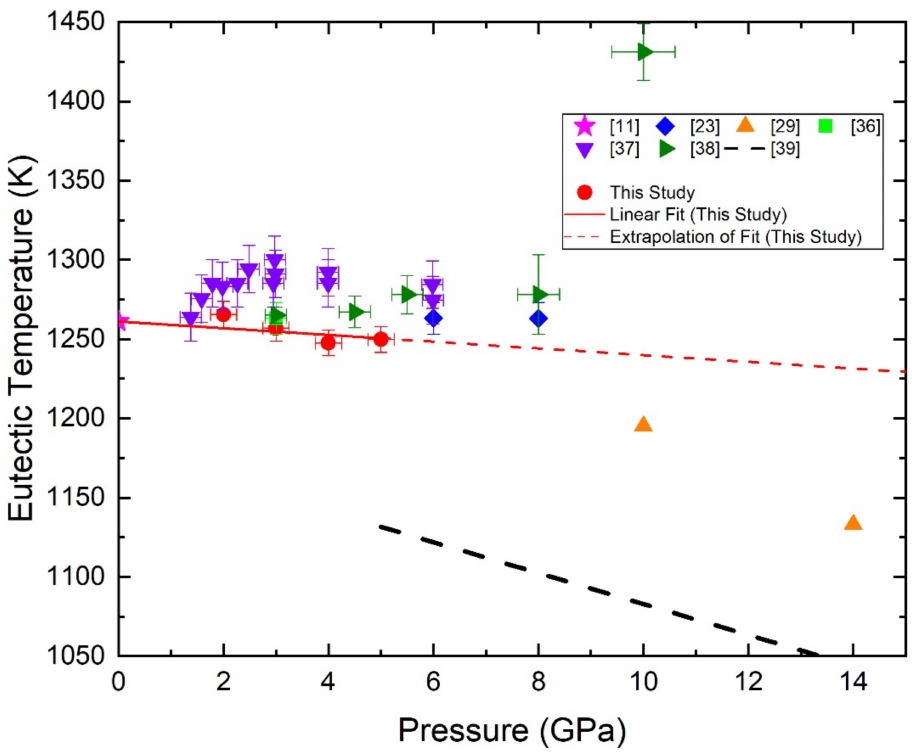
Figure 3. Experimentally determined eutectic temperatures of the Fe-FeS system as a function of pressure. The results of this work are compared to several previous works [11,23,29,36–39]. Estimates of P within the core of Ganymede range from ~5 GPa at the core–mantle boundary (CMB) to ~11 GPa at its center and T at the CMB span ~1250–2100 K [3,5,7,9,10]. We adopted the same procedure to calculate adiabatic heat flow (Q a ) at the top of Ganymede’s core as Littleton et al. [21], although for the current study two linear fits to interpolate and extrapolate values of ρ at 5 GPa between 1250 and 1450 K were used, as shown in the Appendix (Figure A1). A positive linear fit (with ( ∂ ρ / ∂ T) P > 0 µ Ω · cm/K) was used to account for all measurements at T above the estimated eutectic T, while a horizontal linear fit (with ( ∂ ρ / ∂ T) P = 0 µ Ω · cm/K and with ρ = 315 µ Ω · cm) was used to account for all measurements excluding the highest two temperatures. These were excluded because they may indicate the onset of deteriorating thermocouple integrity and W